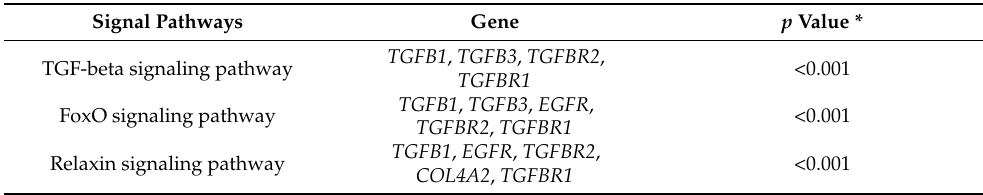
Table 5. Selected signaling pathways and biological processes in which specific differential genes play an important role .